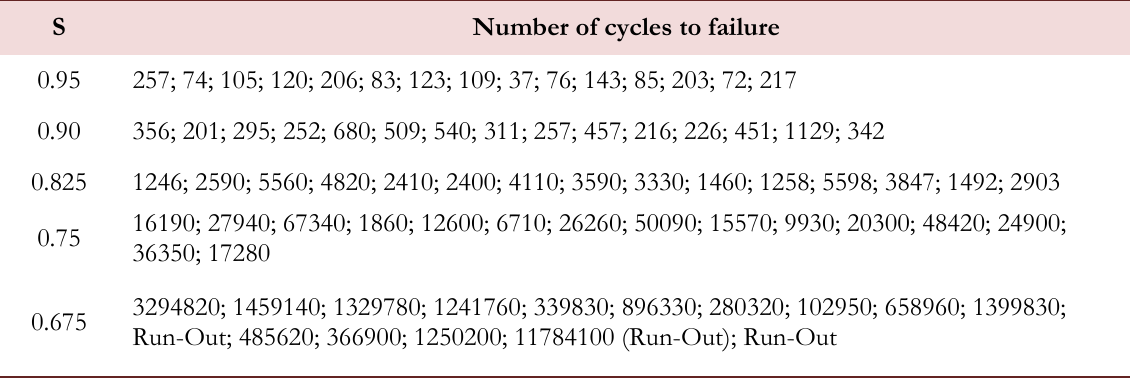
Load collective and basic loading block